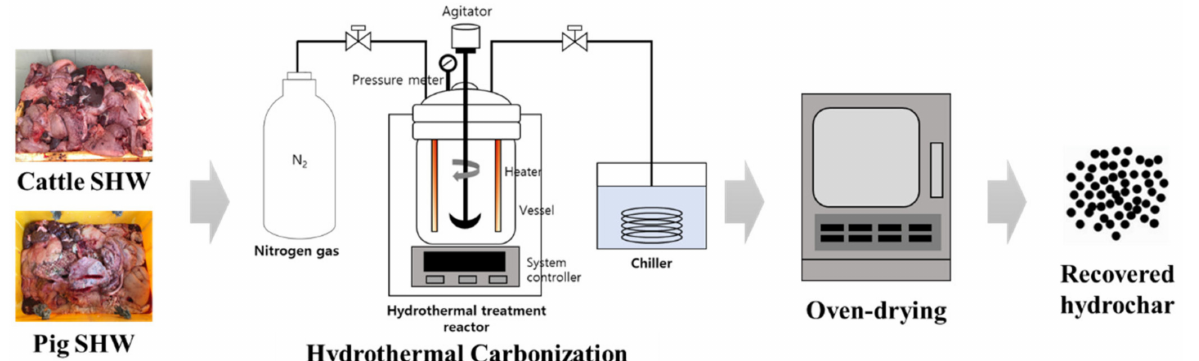
Figure 1. Scheme of experimental